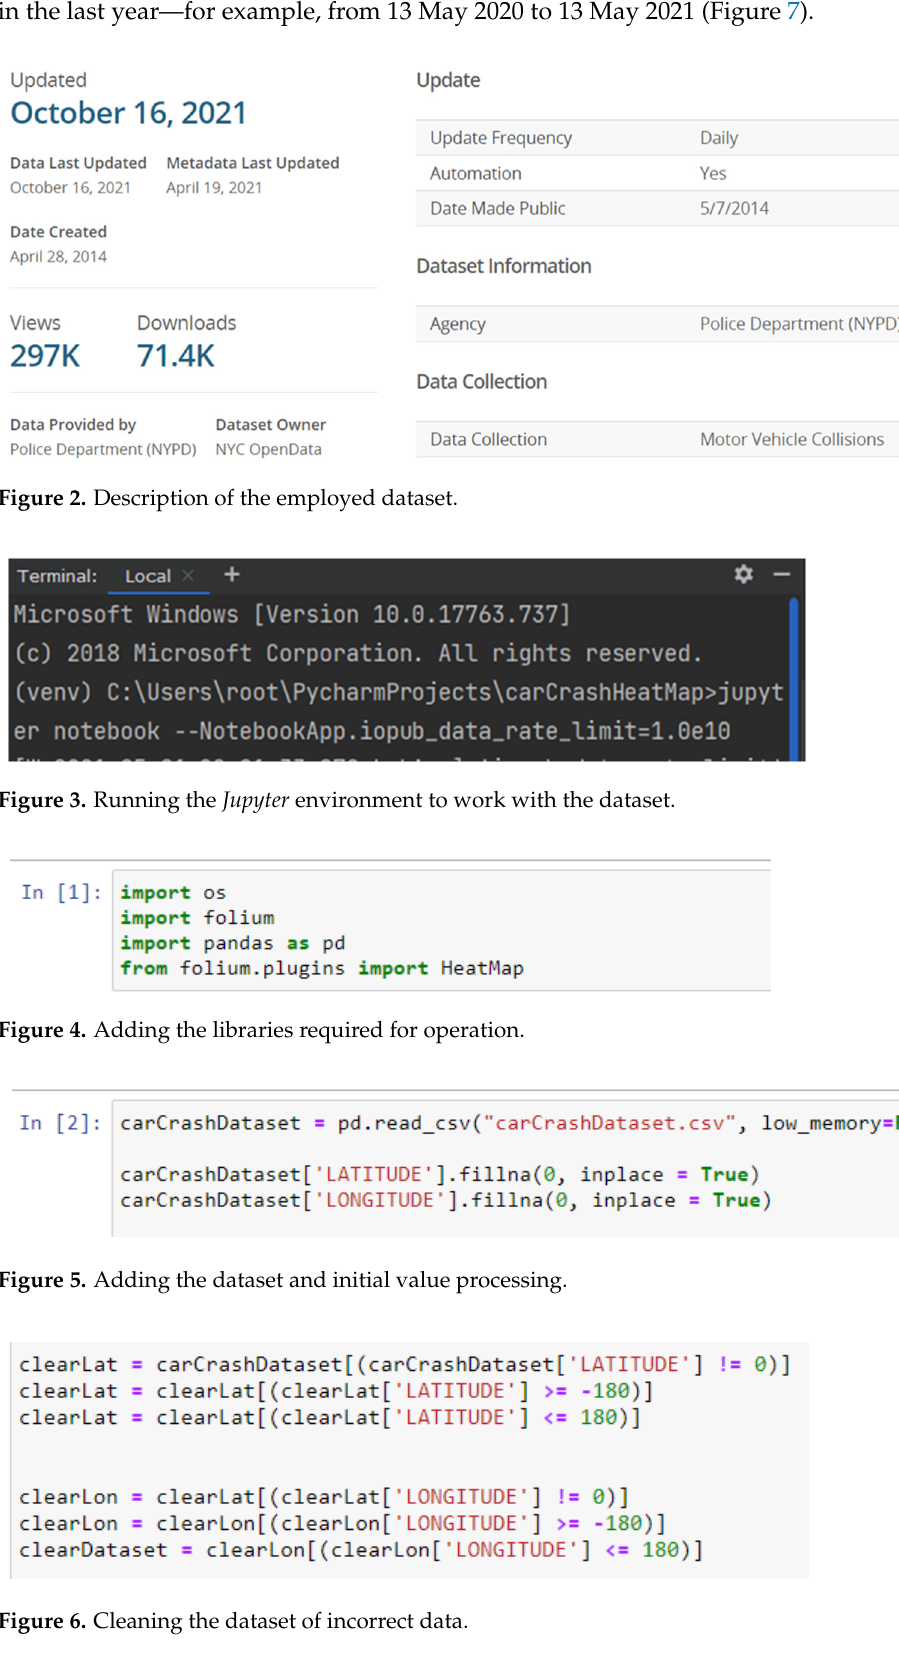
Figure 6. Cleaning the dataset of incorrect data.